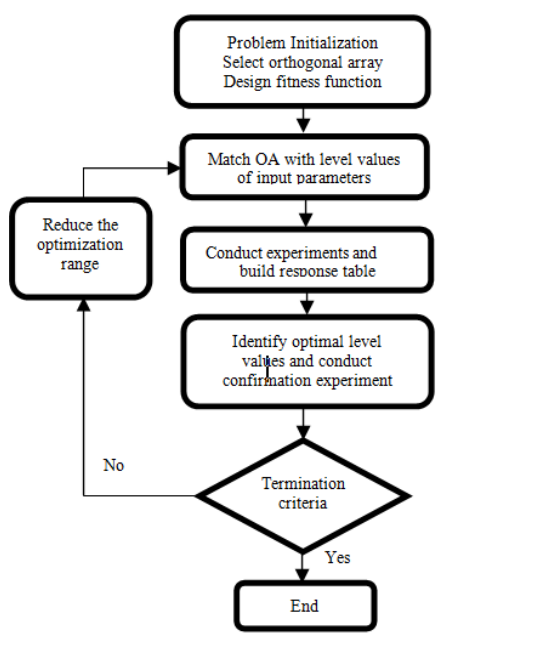
FIGURE 16. Flow chart of Taguchi method [26]-[27]